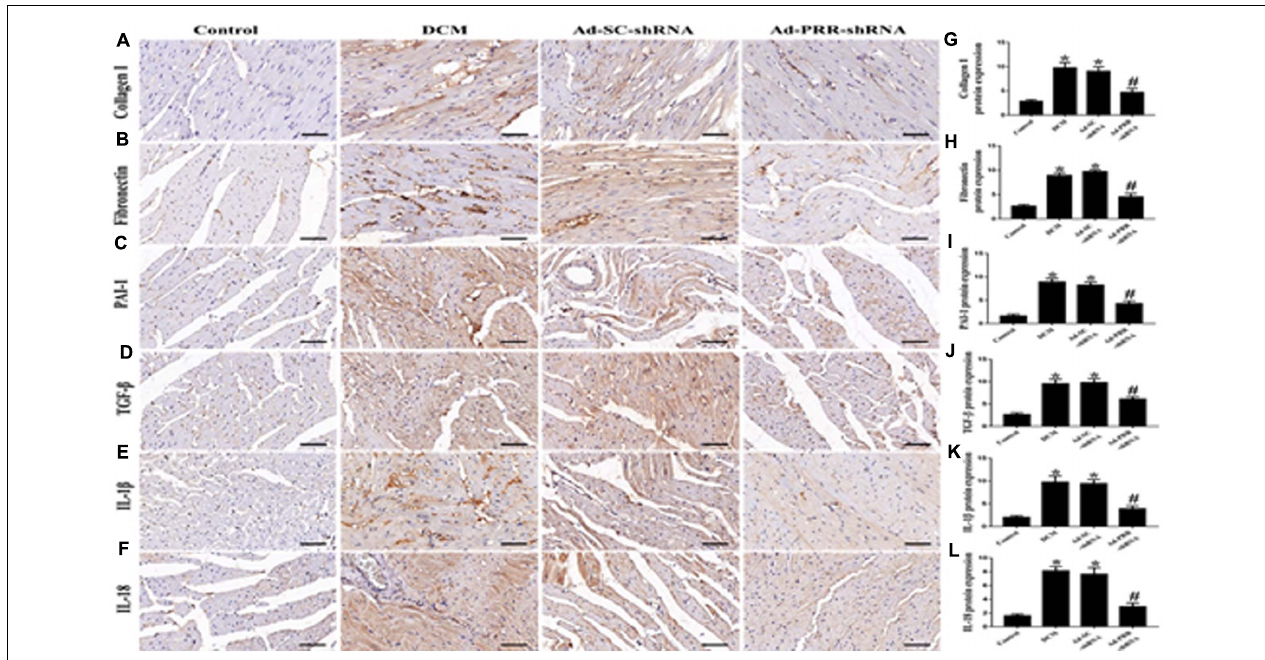
FIGURE 2 | PRR silencing decreased myocardial interstitial fibrosis and inflammation in rats with diabetic cardiomyopathy ( n = 5). (A–F) Representative immunohistochemical staining of Collagen I, Fibronectin, PAI-1, TGF- β , IL-1 β and IL-18 in the 4 groups (scale bar = 20 µ m). ( G–L) Quantitative analysis of the Collagen I, Fibronectin, PAI-1, TGF- β , IL-1 β , and IL-18 protein expression shown in panels (A–F) . * p < 0.05 versus the control group; # p < 0.05 versus the Ad-SC-shRNA